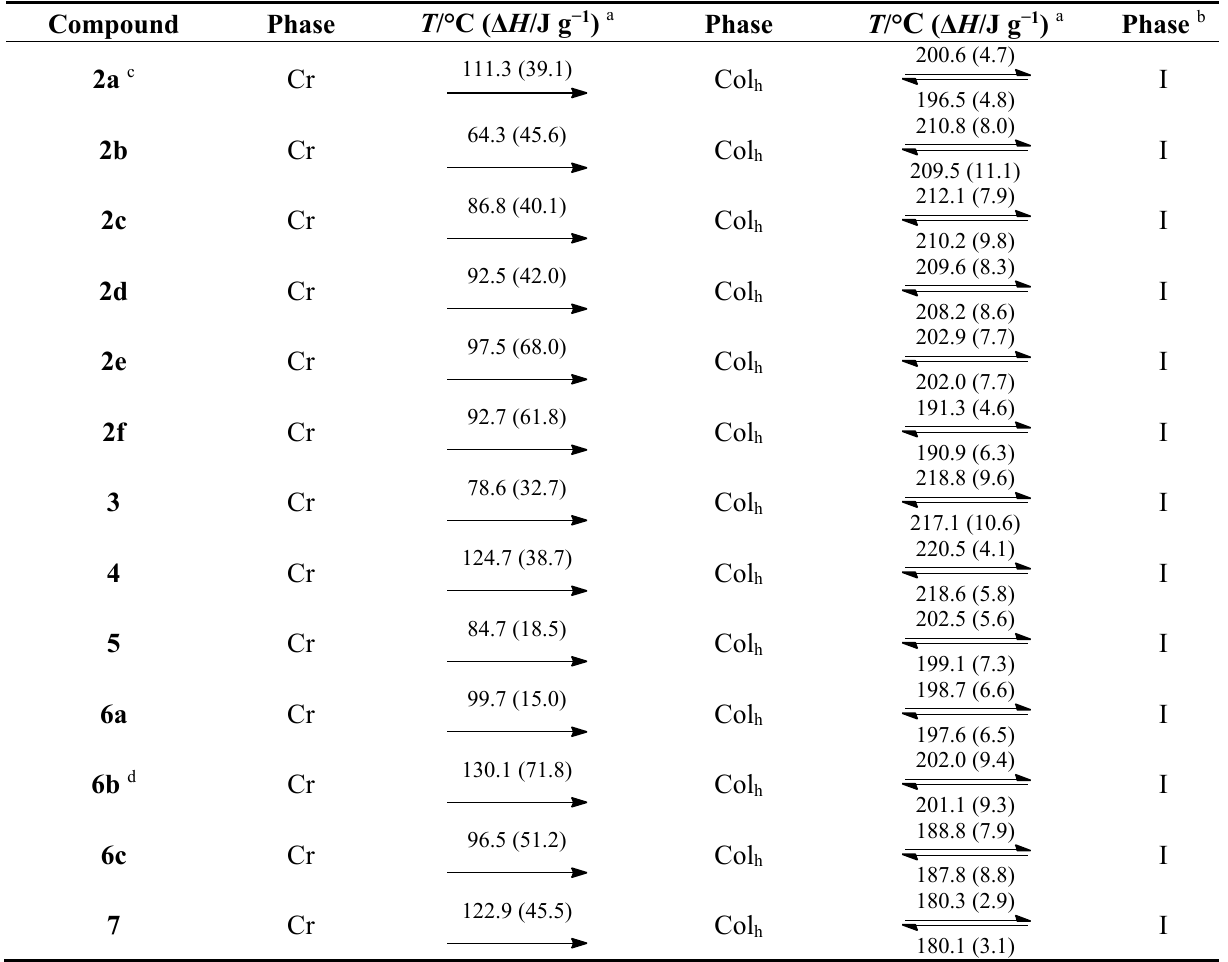
Table 1. Phase behavior of compounds 2–7. a Transition temperatures and enthalpies were determined by differential scanning calorimetry (DSC) (scan rate = 10 °C/min) on second heating run (see text); b Cr = crystal, Col h = columnar hexagonal, I = isotropic; c see reference 11; d see reference 12.